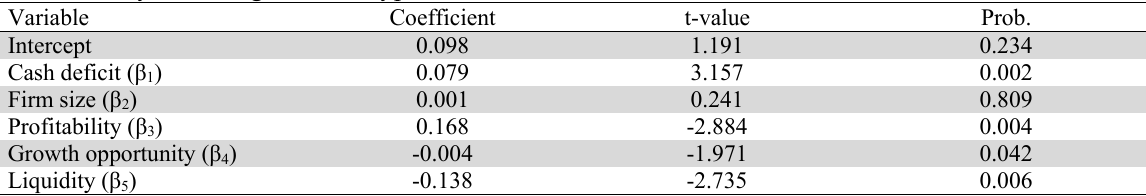
The summary of testing the first